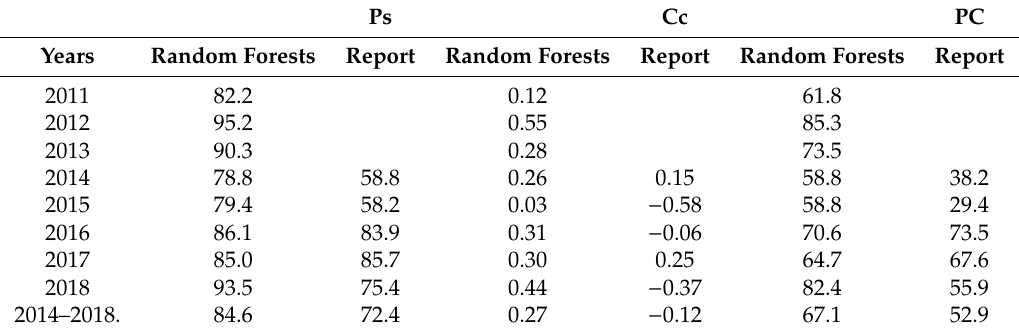
Table 5. Comparison Table of random forest summer precipitation and release forecast from 2011 to